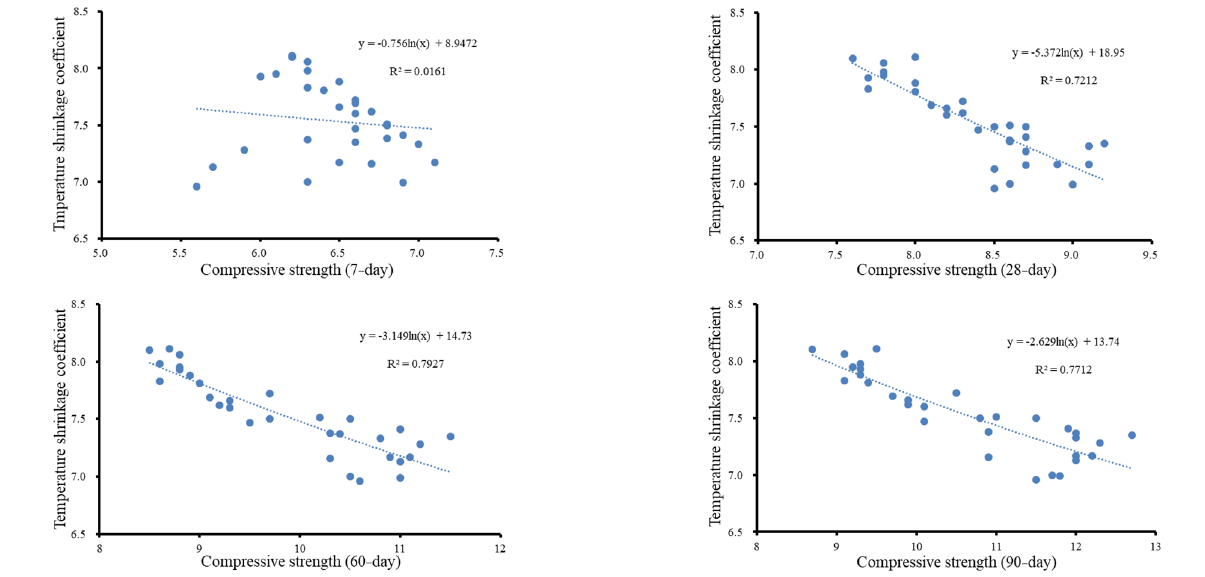
Figure 10. Relationships between compressive strengths and temperature shrinkage coefficients.